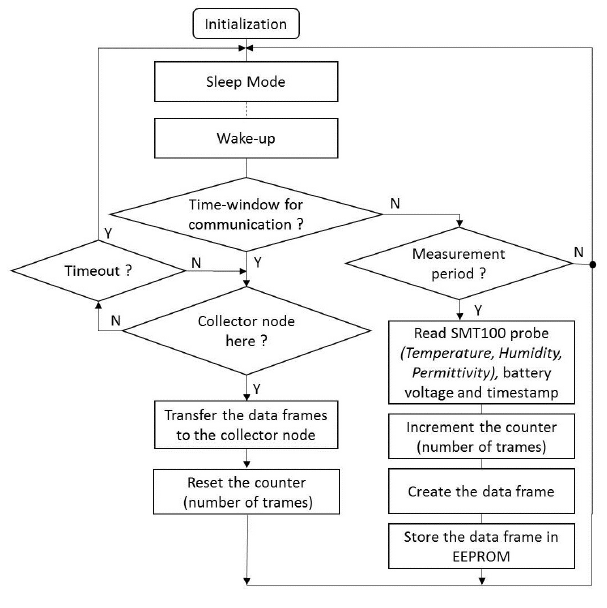
Figure 4. Diagram of the program in a sensor node. Table 1. Structure of a data frame sent by a buried sensor node (25